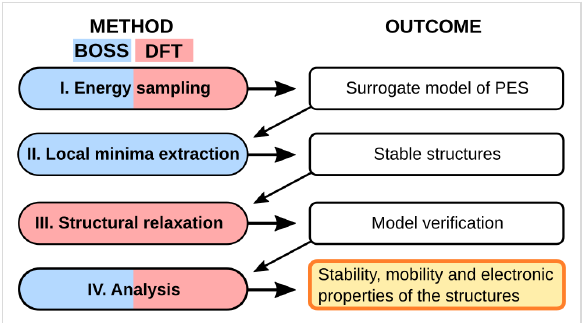
Figure 1: Structure search with BOSS (blue) and DFT (red). (I) The PES is sampled with BOSS by calculating energies of atomic configu- rations with DFT to obtain the surrogate model of the PES. (II) BOSS identifies the stable structures in the minima of the PES. (III) The stable structures are confirmed with full relaxation with DFT, after which (IV) their mobility and adsorption properties are analyzed via the corresponding energy barriers and electronic